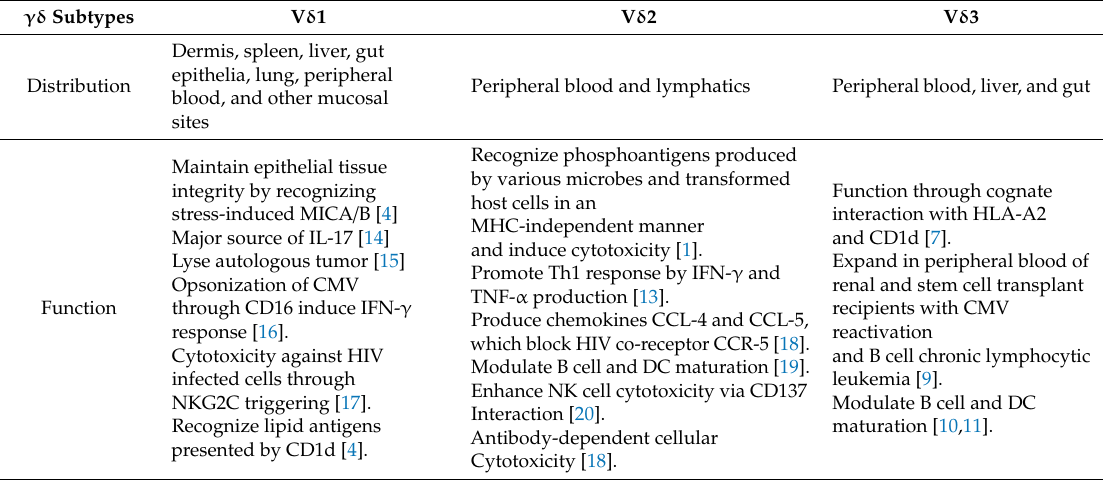
Table 1. Distribution and function of γδ